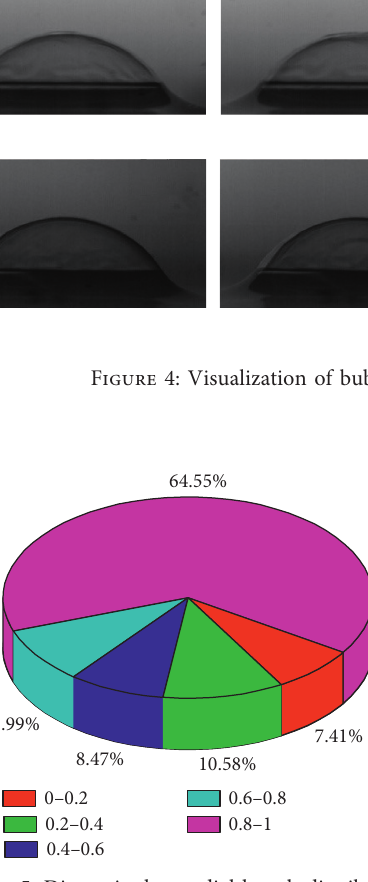
Figure 5: Dimensionless radial length